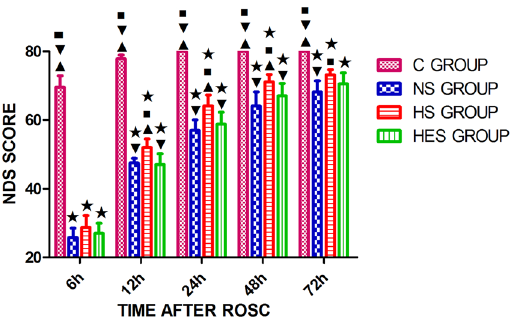
Figure 1. Survival rate and neurological deficit evaluation at various time-points during cardiopulmonary resuscitation (CPR) and after ROSC. NDS of the survived rats assessed during the recovery period at 6, 12, 24, 48 and 72 hours after ROSC. NDS were determined by a scale of 0–80, based on arousal levels: cranial nerve reflexes, muscle tone, motor function, seizure and simple behavioral responses. Score 80 represented normal performances (no deficit); score 0 represented the brain death (most severe neurological deficit). ★ P < 0.05 vs